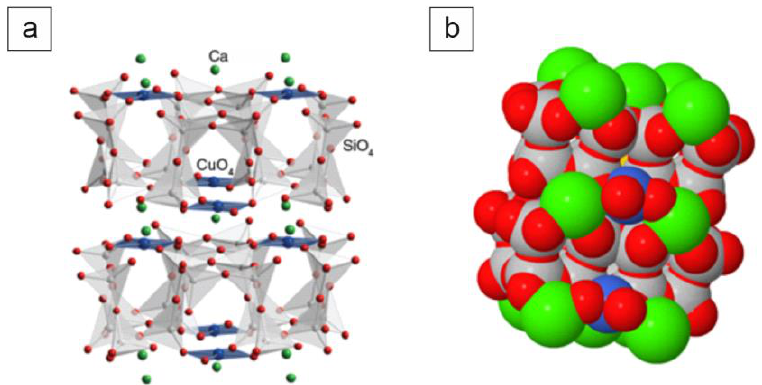
Figure 1. Spatial model of Egyptian blue (calcium copper tetrasilicate, CaCuSi 4 O 10 ), ( a ) model with highlighted silicon SiO 4 sites and copper CuO 4 sites, ( b ) model with visible Ca cations, source ChemTube3D by Nick Greeves, licensed under CC BY-NC-SA 2.0 UK.